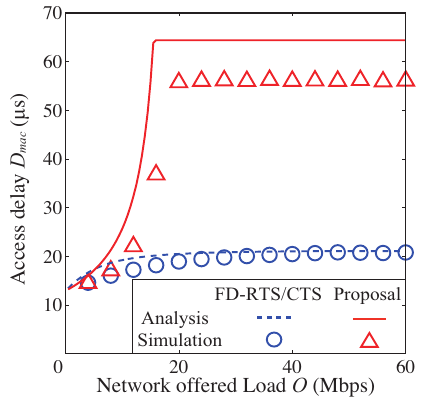
Figure 10. Access delay as a function of offered load for N = 5.